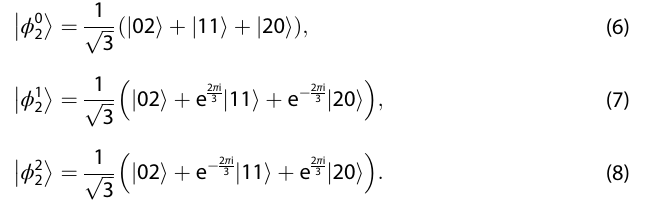
Table 1. Charlie ’ s measurement probability for both